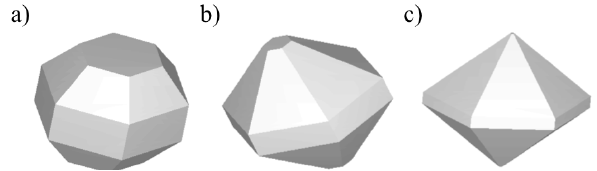
Fig. 8. Examples of 3Bs with D = 50µm and 20 regular and 12 irregular hexagonal columns whose length varies. The corresponding area ratios are (a) 0.85, (b) 0.77, and (c) 0.69.